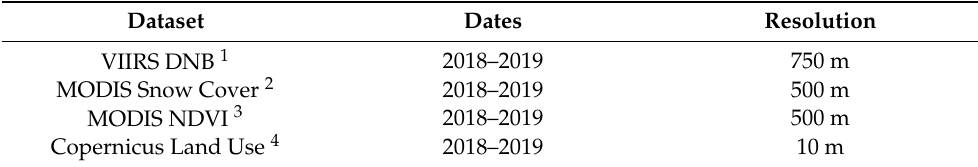
Table 2. Study dataset names, spatial resolution, and links from which they can be